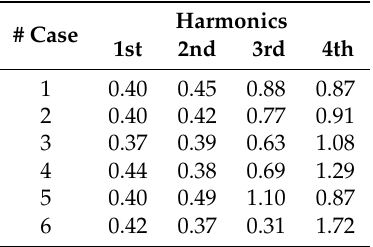
Table 2. Relative Error (%) of Harmonic Amplitudes for Generation Test Cases.